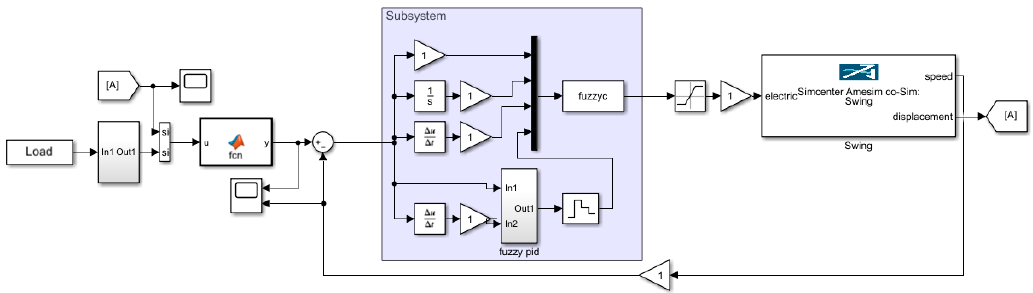
Figure 12. Co-simulation model of AMESim and Simulink.